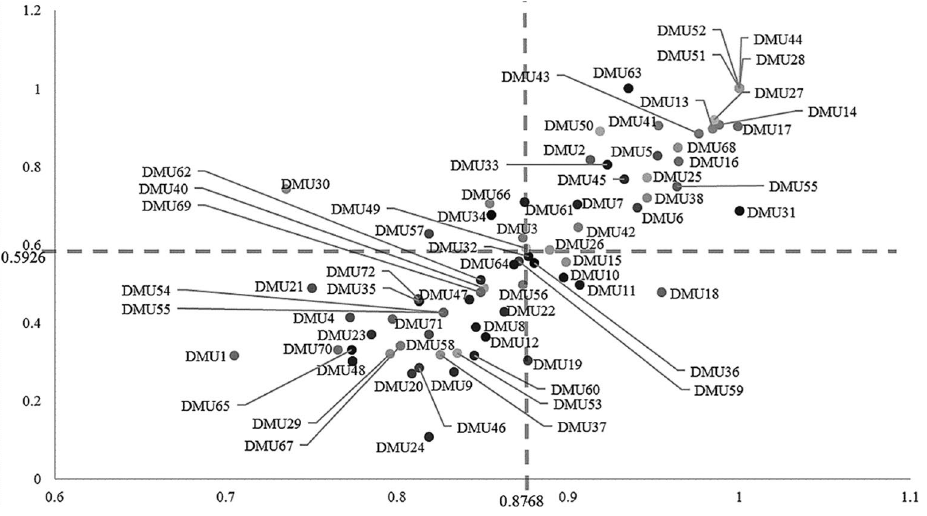
Figure 2. Managerial decision matrix based on the average score of the managerial performance over 7-year